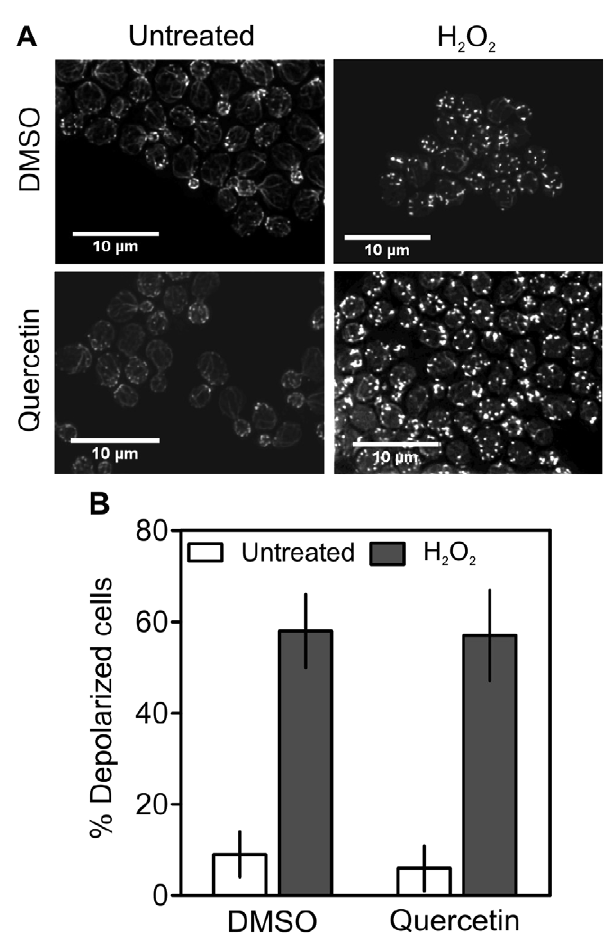
Figure 6. Quercetin does not affect H 2 O 2 -induced actin de- polarization. Yeast cells were grown to exponential phase and pre- treated with 300 m M of quercetin or equal volume of DMSO (control cells) for 15 min and subsequently exposed to 1.5 mM H 2 O 2 for 1 h. Cells were incubated with rhodamine-phalloidin to stain actin and visualized on a fluorescence microscope. (A) Deconvolved and stack fluorescence images of cells with actin staining; (B) Percentage of depolarized cells obtained after counting approximately 1500 cells for each treatment condition. Data represent the mean 6 SD of three independent